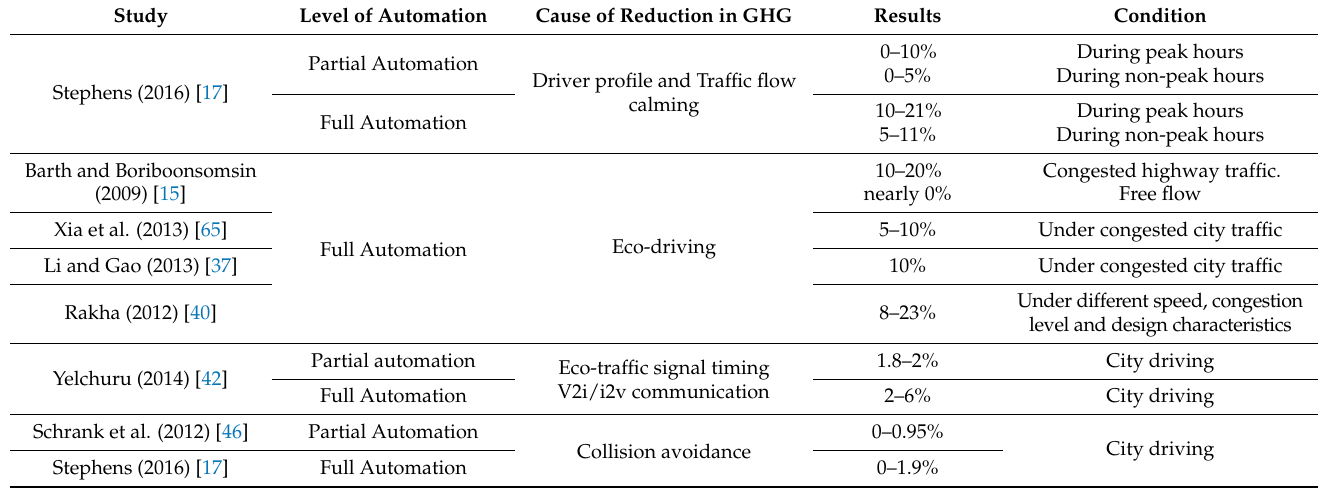
Table 1. Reduction of GHG emission at different levels of vehicle